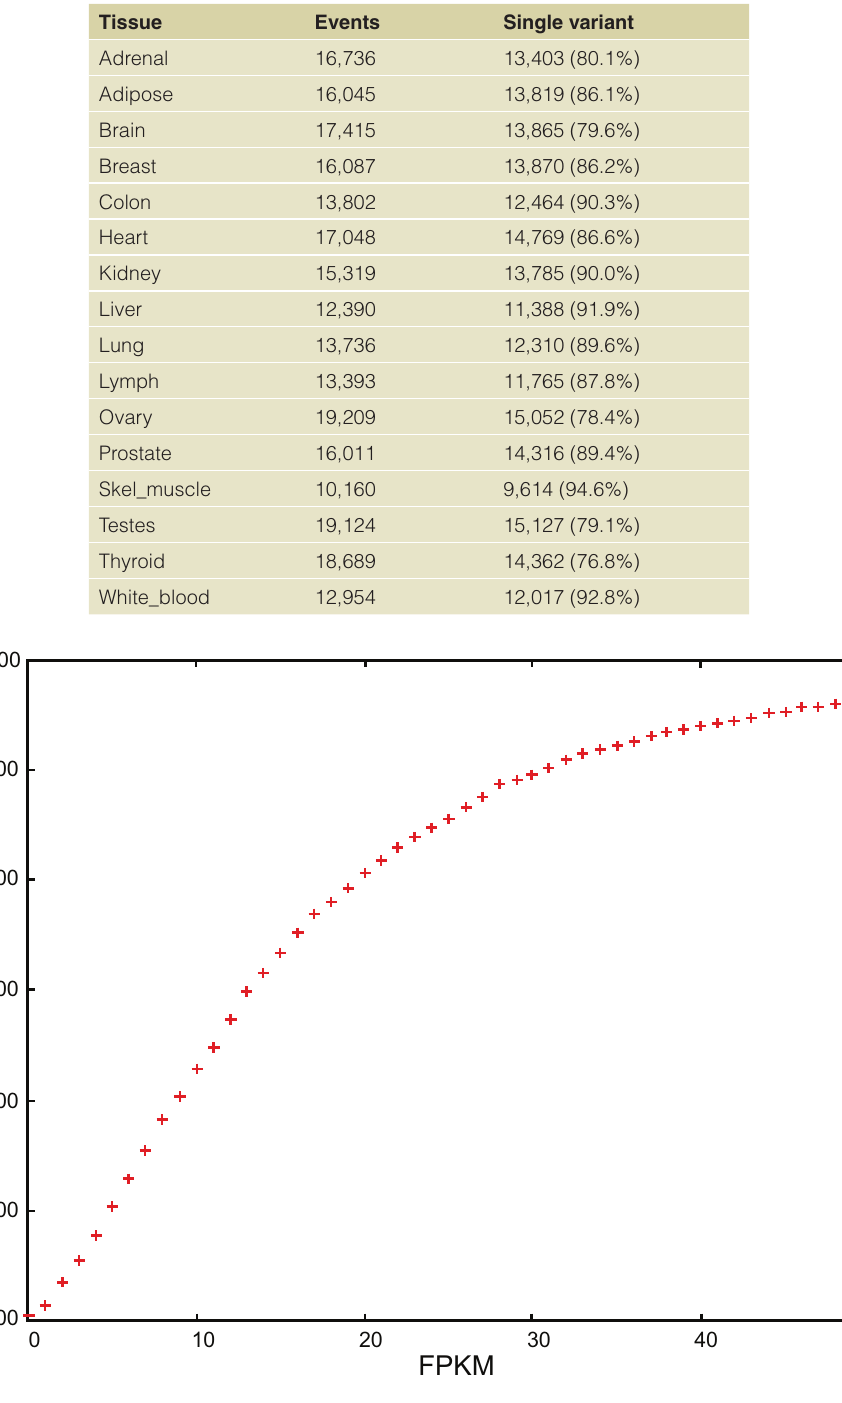
Figure S12. Expression levels of genes for the 13,946 events not comparable between adrenal and adipose tissues. 2,085 (15.0%) event genes are not expressed (FPKM<0.1), whereas 3,487 (33.7%) have FPKM values less than 10.0 and therefore may be incompletely reconstructed, which can cause a splice form to be